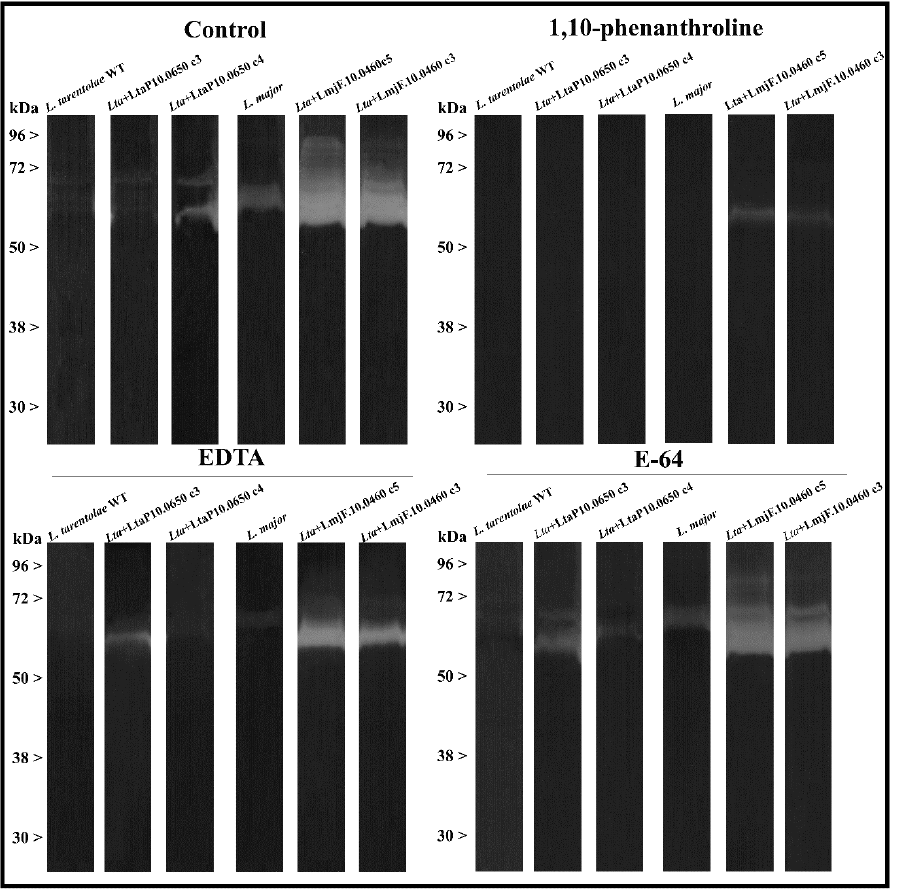
Figure 4. Proteolytic activity of leishmanolysins from L. tarentolae , L. major and their mutants Figure 4 . Proteolytic activity of leishmanolysins from L. tarentolae , L. major and their mutants by Gelatin-SDS-PAGE zymography. The soluble extracts of wild-type L. tarentolae (WT), L. major, by Gelatin-SDS-PAGE zymography. The soluble extracts of wild-type L. tarentolae (WT), L. major, and two isolates from each cloned leishmanolysins ( LmjF.10.0460 and LtaP10.0650 ) were submitted and two isolates from each cloned leishmanolysins ( LmjF.10.0460 and LtaP10.0650 ) were submitted to to Gelatin-SDS-PAGE electrophoresis. The gels were incubated in 50 mM phosphate buffer pH 5.5 Gelatin-SDS-PAGE electrophoresis. The gels were incubated in 50 mM phosphate buffer pH 5.5 for for 72 h at 37 °C. To confirm the enzymatic class, zymograms were incubated in the absence (control) 72 h at 37 ◦ C. To confirm the enzymatic class, zymograms were incubated in the absence (control) or or presence of the ion chelators 1-10-phenanthroline and EDTA at 10 mM and E-64 at 10 µM to exclude cysteine peptidases activity around 63 kDa. The numbers on the left indicate apparent mo- presence of the ion chelators 1-10-phenanthroline and EDTA at 10 mM and E-64 at 10 µ M to exclude lecular masses of the active bands expressed in kDa. cysteine peptidases activity around 63 kDa. The numbers on the left indicate apparent molecular masses of the active bands expressed in kDa. To better evaluate the differences between the proteolytic activity of L. tarenrolae and L. major leishmanolysins, we performed solution assays with the extracts of one clone of each overexpressed peptidase employing a specific matrix metallopeptidase substrate. Af- Table 2. Effects of inhibitors on the proteolytic activity of overexpressed Leishmania tarentolae leishmanolysins. ter 40 min, the substrate was fully hydrolyzed by the soluble extract of the L. major leish- manolysin clone, and this proteolytic activity was almost completely inhibited in the pres- Overexpressed Class of Inhibition Residual Activity Inhibitor ence of 1,10-phenanthroline, corroborating our previous findings in gelatin zymography Leishmanolysin or Concentration (Figure 5). However, the overexpressing L. tarentolae leishmanolysin degraded about three times less substrate than the L. major enzyme. Furthermore, the presence of the serine pep- tidase inhibitor PMSF and the cysteine peptidase inhibitor E-64 had a slight effect on the activity of both leishmanolysin clones, while the ion chelators EDTA and EGTA partially